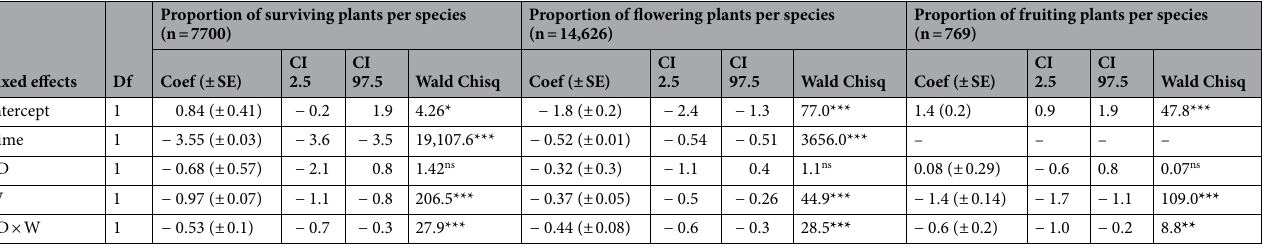
Table 1. Generalized linear mixed models (GLMMs) for the proportion of surviving, flowering and fruiting plants per species and pot. Dependent variables were modelled using binomial error distributions and logit link functions. Pot identity (n = 110) and taxonomic composition (n = 4) were included in the model as random factors. Sampling moment (time) was considered as the number of days since the beginning of the experiment and used as a covariate (n = 10 for surviving plants and n = 19 for flowering plants). We did not consider the sampling moment to model the proportion of fruiting plants, because this variable was just the